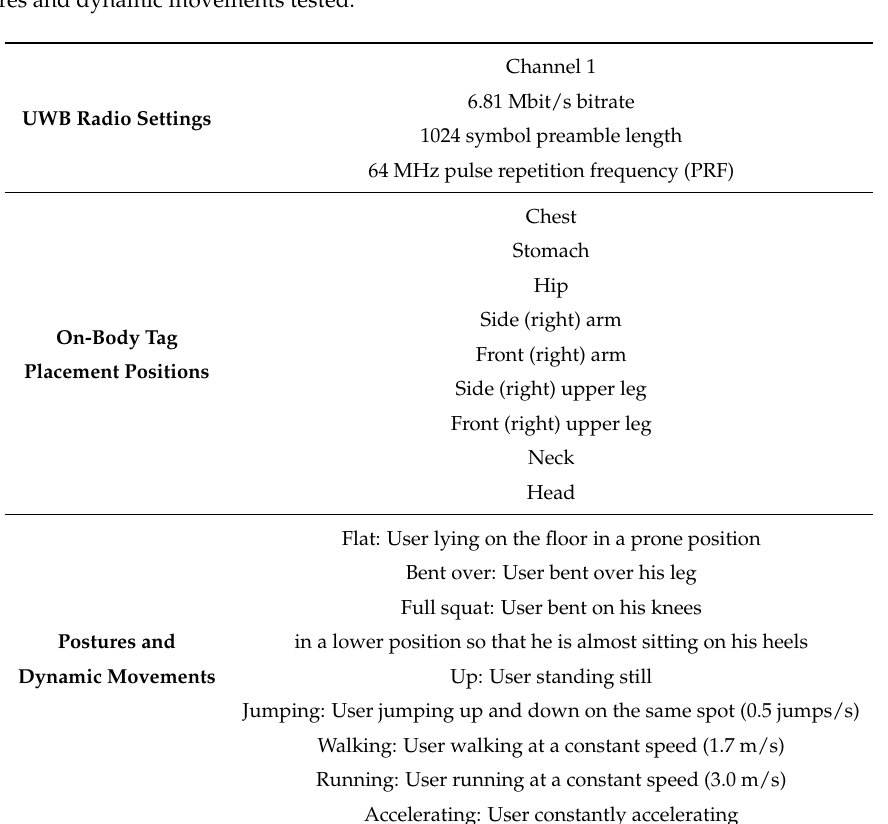
Table 1. Experimental overview. UWB radio settings, UWB tag positions on the human body, Postures and dynamic movements